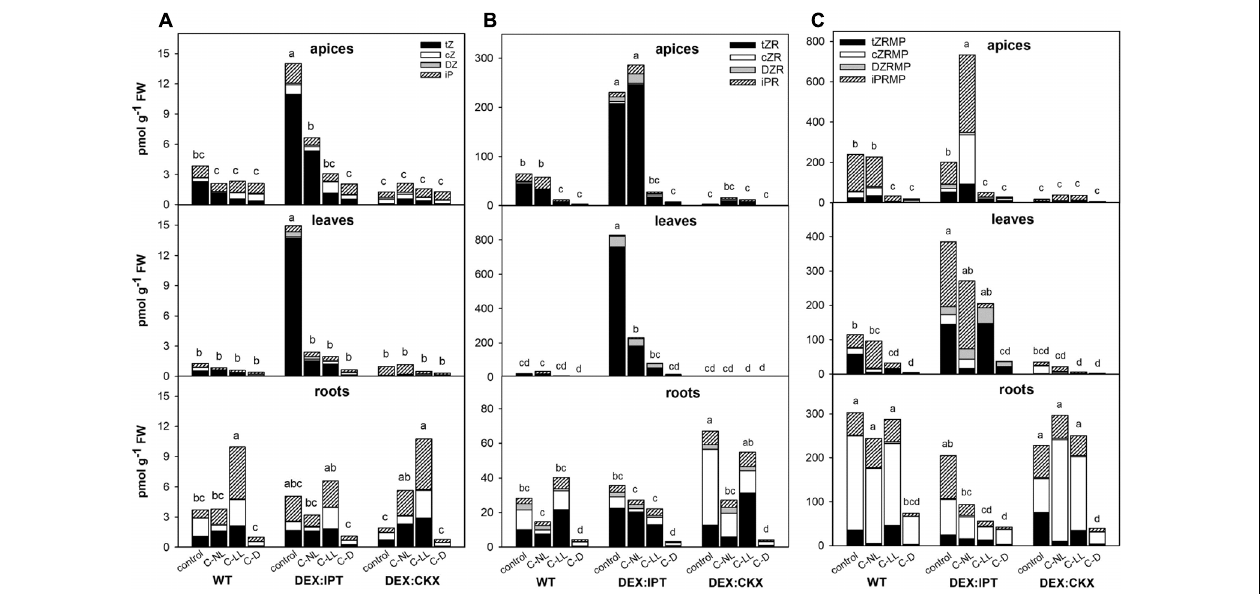
FIGURE 2 | The levels of (A) CK bases [ trans -zeatin (tZ), cis -zeatin (cZ), dihydrozeatin (DZ), and N 6 -( (cid:49) 2 -isopentenyl)adenine (iP)]; (B) CK ribosides [ trans -zeatin riboside (tZR), cis -zeatin riboside (cZR), dihydrozeatin riboside (DZR), and N 6 -( (cid:49) 2 -isopentenyl)adenosine (iPR)]; and (C) CK phosphates [ trans -zeatin riboside monophosphate (tZRMP), cis -zeatin riboside monophosphate (cZRMP), dihydrozeatin riboside monophosphate (DZRMP), and N 6 -( (cid:49) 2 -isopentenyl)adenosine monophosphate (iPRMP)] in apices, leaves, and roots of wild-type (WT) and transformants with high CK synthesis after activation by dexamethasone ( DEX:IPT ), and high CK degradation after activation by dexamethasone ( DEX:CKX ) exposed to cold treatments under different light conditions (see Table 1 for the description). The expression of the transgenes was activated by dexamethasone (DEX). The statistical analyses of the total CK bases/ribosides/phosphates content were performed among all experimental variants within each tissue by one-way ANOVA with Tukey’s post hoc test in four independent biological replicates (significant differences at p < 0.05, n = 4, are indicated by different letters). Means ± SD and detailed statistics of individual CKs are shown in Supplementary Table 2 .